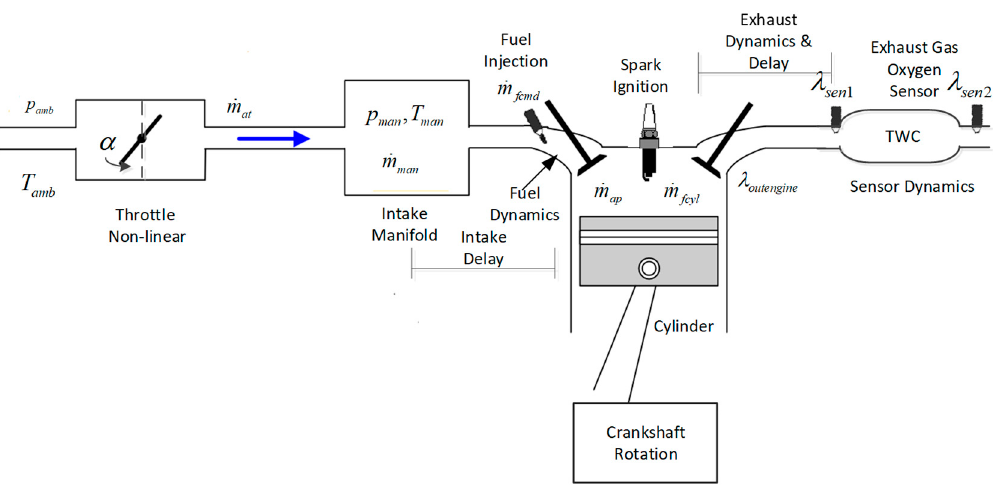
Figure 1. Structure of the SI engine air path.